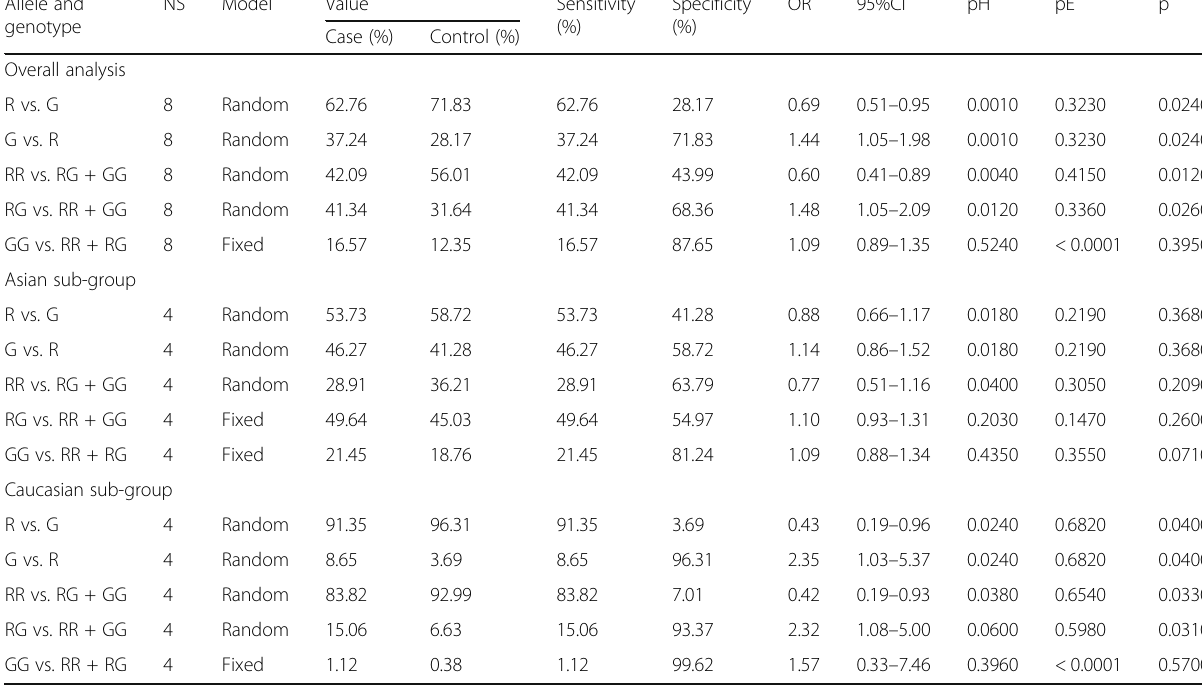
Table 4 Summay of the association between R990G gene polymorphism and the risk of urolithiasis Allele and